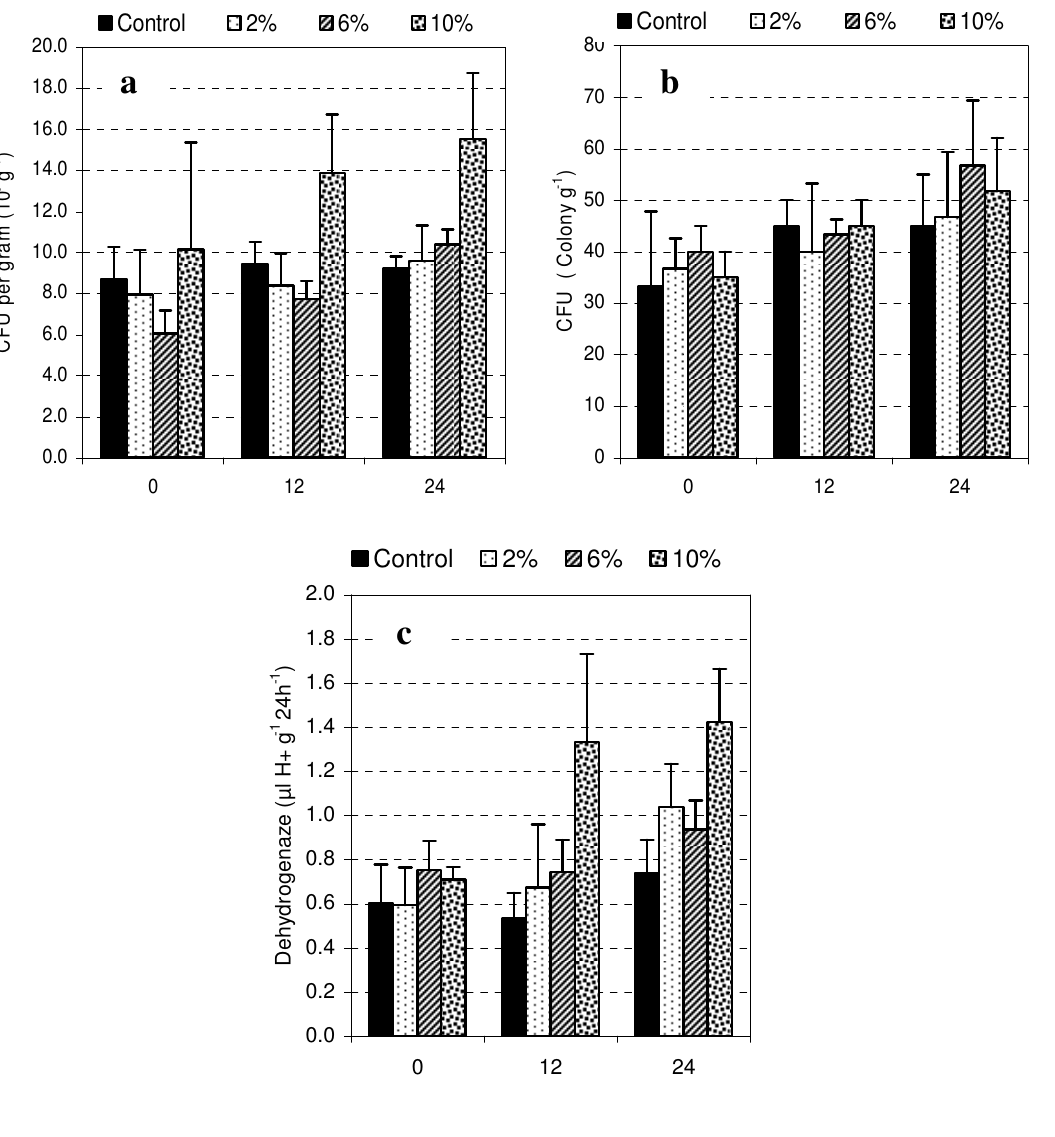
Fig. 2. Effect of incubation of a combination of Trichoderma harzianum and organic amendment in the soil on: a, total fungal population (CFU, 10 6 g -1 ); b, Rhizoctonia solani population (CFU, colony g -1 ); c, T. harzianum population (CFU, 10 6 g -1 ); d, dehydrogenase enzyme activity (hydrogen ions, μ l g -1 24 h -1 ). Vertical bars represent the standard deviation of replicates from the